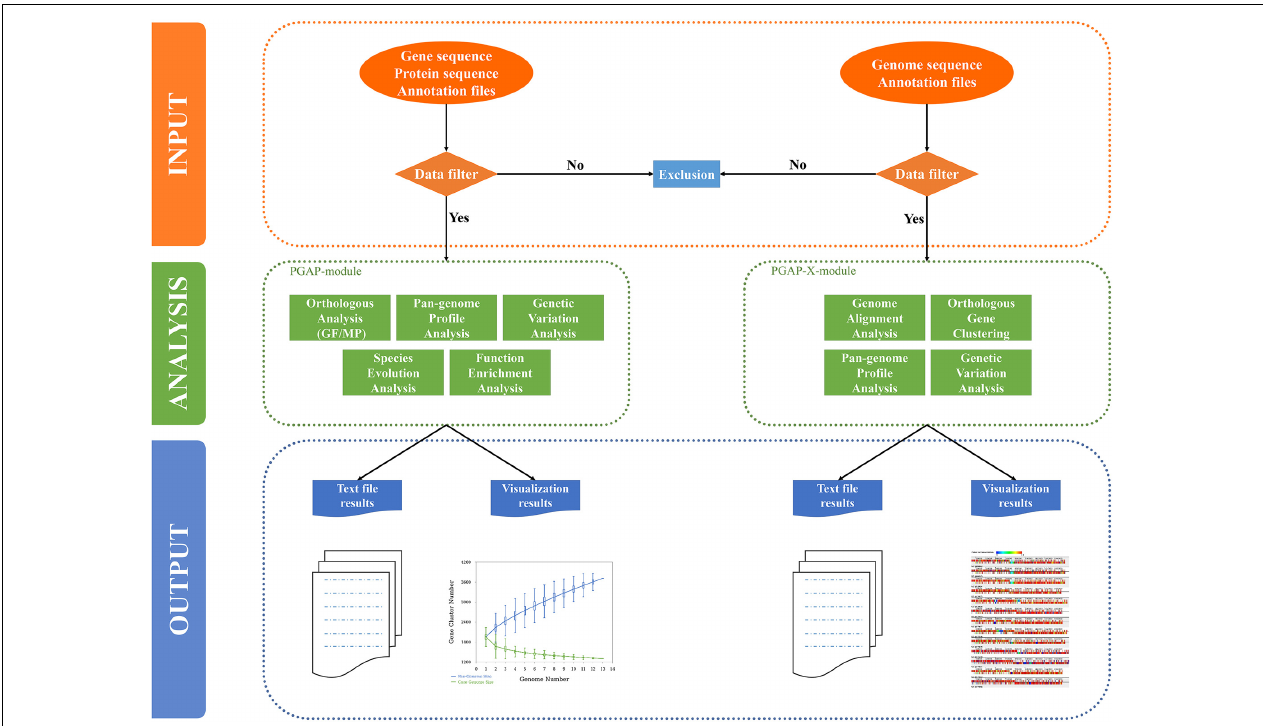
FIGURE 1 | Organization of PGAweb. All analysis steps are grouped into three parts: data input, data analysis, and output-visualization (shown with different color codes and separated by dashed lines). The input data of each module will be checked. The filtered data will be used in the subsequent analysis. Green boxes report the analysis functions of each module. For the output, PGAweb provides one text file corresponding to a graph (genetic variation analysis in the PGAP module only provides tabular